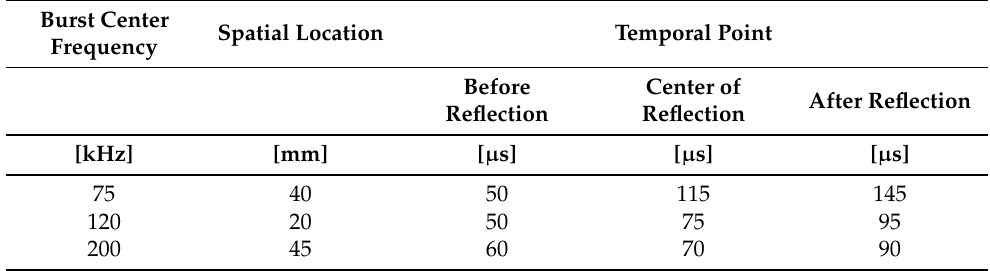
Table 5. Points in time and location used to identify the first reflected wave packages in Figure 11 with a spatial CWT evaluation, cf. Figure 13. Burst Center Spatial Location Temporal Point Frequency Before Center of Reflection